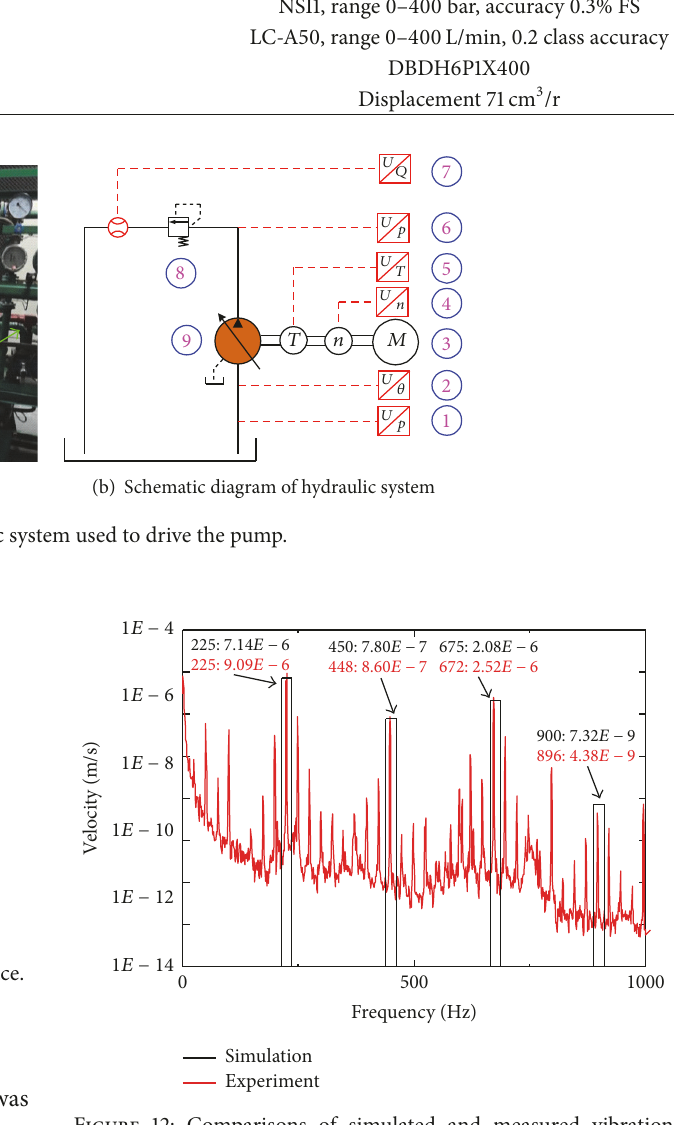
Figure 12: Comparisons of simulated and measured vibration